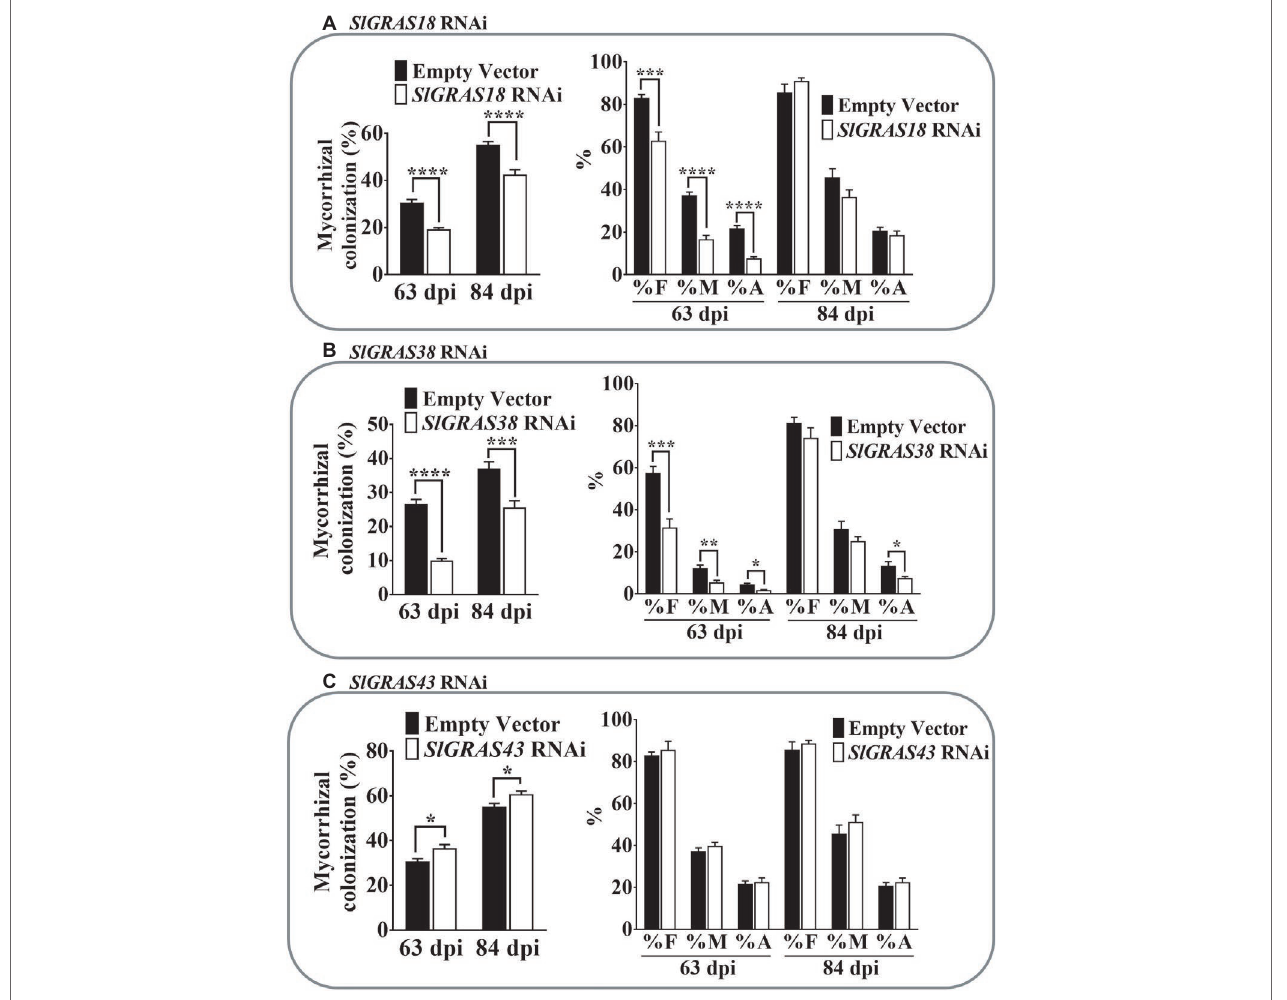
FIGURE 7 | Mycorrhizal colonization parameters in roots of SlGRAS18 , SlGRAS38 , and SlGRAS43 RNAi AM-inoculated composite tomato plants. Percentage of colonized root length (graphs on left) and mycorrhization parameters (graphs on right) were analyzed after 63 and 84 dpi (days post inoculation) with the AM-fungus R. irregularis in hairy roots silenced for different GRAS genes. (A) SlGRAS18 RNAi hairy roots. (B) SlGRAS38 RNAi hairy roots. (C) SlGRAS43 RNAi roots. Values correspond to mean ± SE ( n = 5). Bars with the same letter do not significantly differ. Significant differences (Student’s t test) between the mutant and the control are indicated with asterisks (* p < 0.05; ** p < 0.01; *** p < 0.001; **** p <